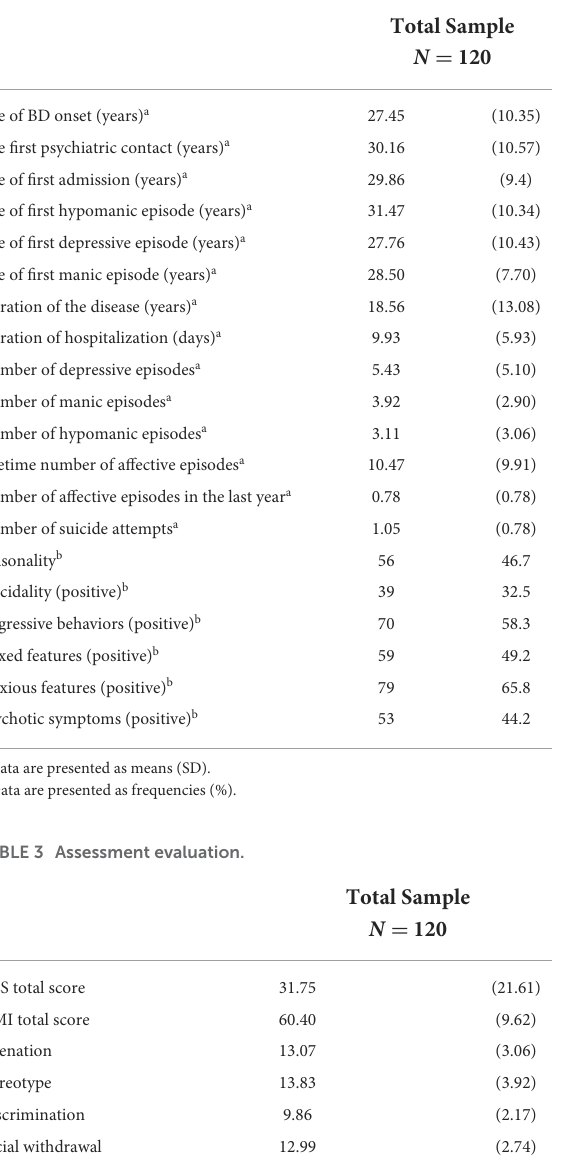
TABLE 2 Clinical features of the sample.